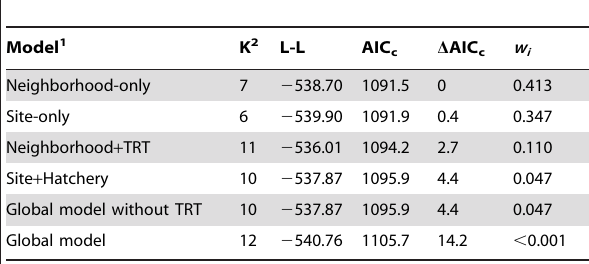
Table 2. Model selection metrics for hurdle count regression models fit to occurrence and abundance data for steelhead redds at 209 sites in the John Day River basin,